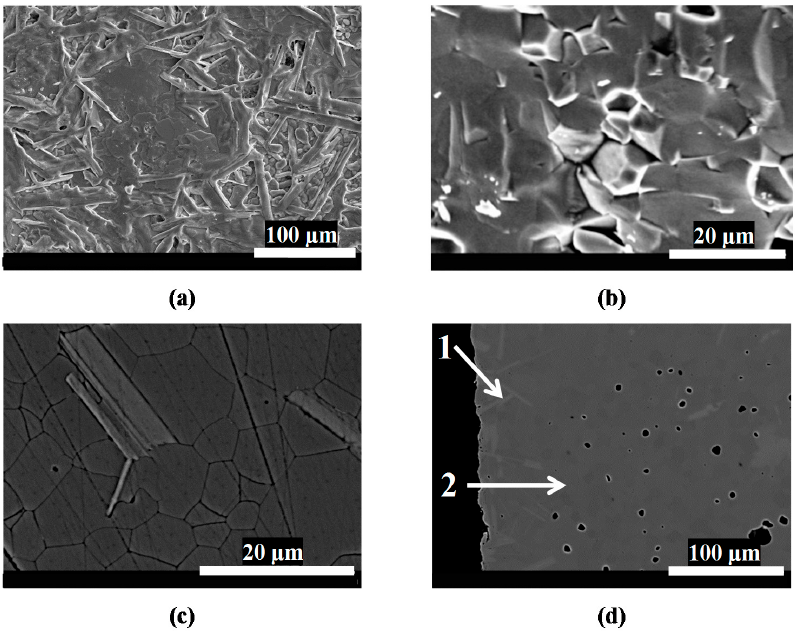
Figure 7. SEM micrographs of BCZN ceramics ( S1a ): ( a ) of a surface; ( b ) of a fractured surface; ( c ) of a grain boundary; and ( d ) of a longitudinally polished section. The atomic percentages derived from the EDS spectra are given in Table 1.